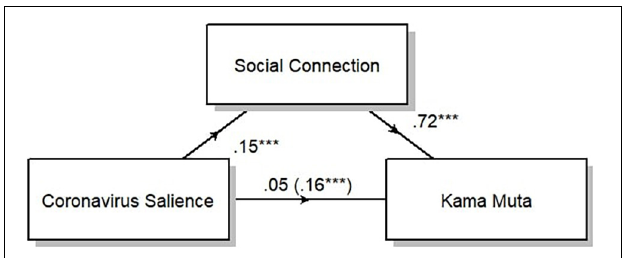
FIGURE 3 | Social connection completely mediates the effect of coronavirus salience on kama muta. The diagram displays the average direct effects (0.05), the total effect (0.16), the effect of coronavirus salience on social connection (0.15), and the effect of social connection on kama muta (0.72). *** p <